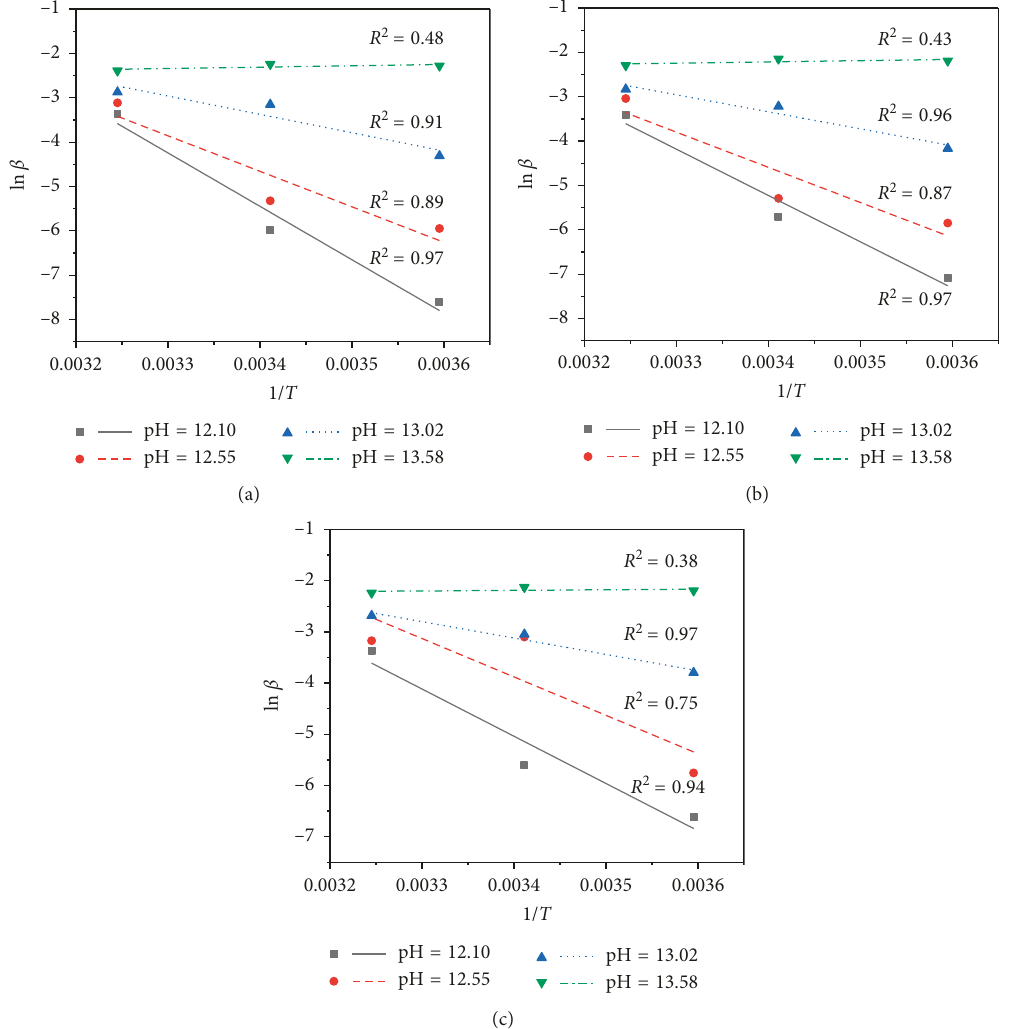
Figure 4: Effect of curing temperature on the hydration rate β at different w/s ratios for 3days: (a) w/s